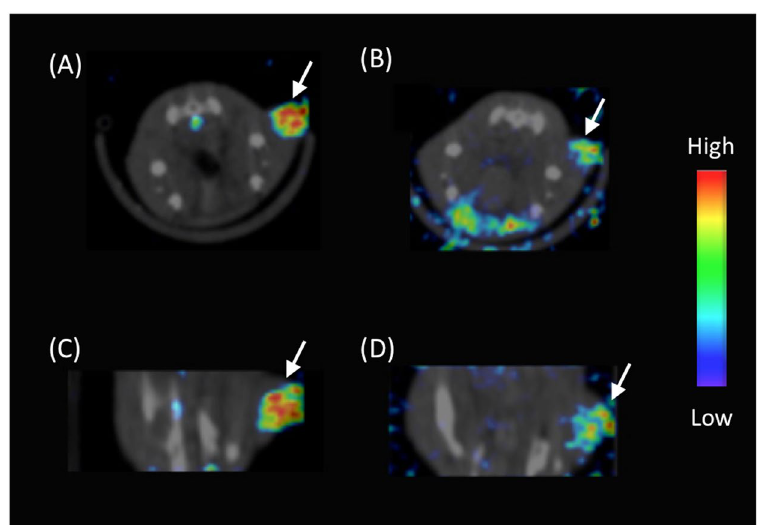
Figure 14. SPECT/CT images of an N87 tumor-bearing mouse at 8 h ( A and C ) and 24 h ( B and D ) after the injection of [ 123 I] 4 -trastuzumab ( A and B : transversal image, C and D : coronal image). The white arrows indicate the